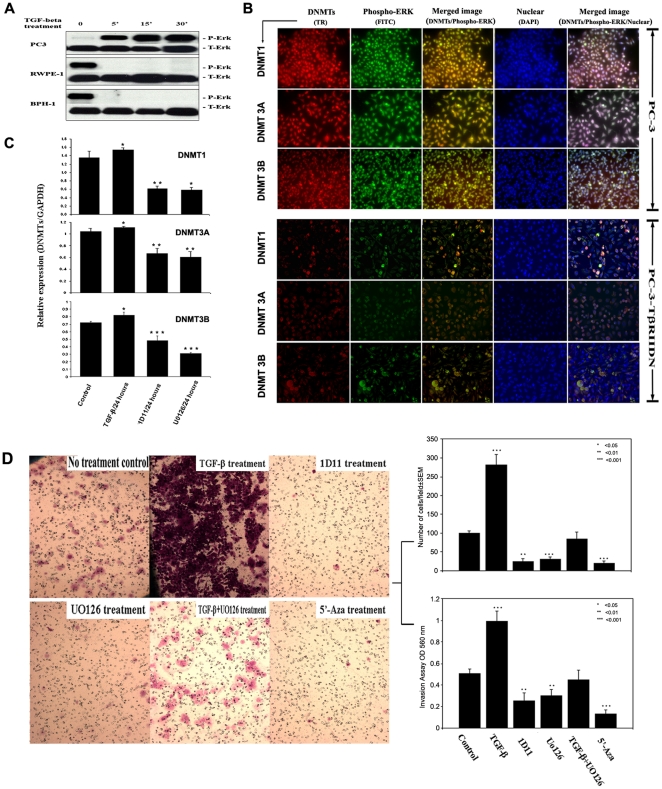
TGF-β induced DNMTs is mediated by ERK activation.
A. The benign BPH-1 and RPWE-1 cells express significantly higher baseline levels of p-ERK than the PC-3 cells. There is a time dependent positive correlation between treatment with TGF-β1 and the expression of p-ERK in PC-3 cells. The levels of p-ERK continue to increase during all subsequent time points up to 30 minutes after TGF-β1 addition. In contrast, the expression of p-ERK is rapidly (<5 minutes) inhibited after TGF-β1 exposure in benign cells in a fashion that is independent of the total ERK protein expression. B. Immunofluorescence reveals that only cells (this is PC3 for example) expressing p-ERK exhibit DNMT expression. In contrast, when PC-3 cells are rendered insensitive to TGF-ß1 by TβRIIDN, levels of both p-ERK and DNMT are significantly reduced (magnification: 10×20). C. We performed real time PCR to better quantify the relationship between TGF-β1, p-ERK and DNMTs. Exposure to TGF-β1 significantly increased the expression of all three DNMTs in PC-3 cells. Treatment with 1D11, or MEK inhibitor, UO126 is associated with the down-regulation of all DNMT mRNA expression. D. (Here we showed most aggressive PC-3M as a sample). There was a significant increase in cell motility through a Matrigel-coated polycarbonate membrane under the treatment of TGF-β1 (10 ng/mL). The invasion of all CaP cells could be inhibited by blocking the TGF-β signal by 1D11 or using a p-ERK inhibitor UO126, or DNMT inhibitor 5-Aza separately. The inhibition of invasion by UO126 can't be reverted by TGF-β treatment. Upper right panel: Corresponding numbers of invasive cells. Bottom right panel: absorbance values. This result indicates p-ERK mediated TGF-β-induced DNMT potentiates the invasive ability of prostate cancer cell lines. (magnification, 10×10).